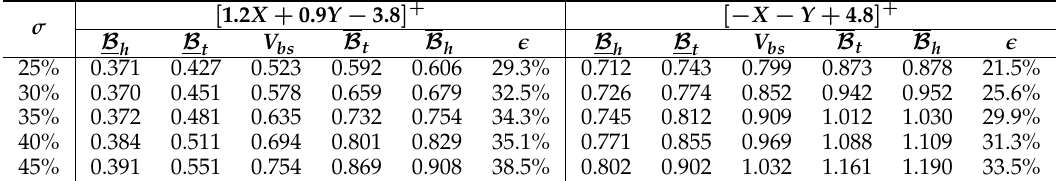
) and foreign interest rate ( r f ) , d